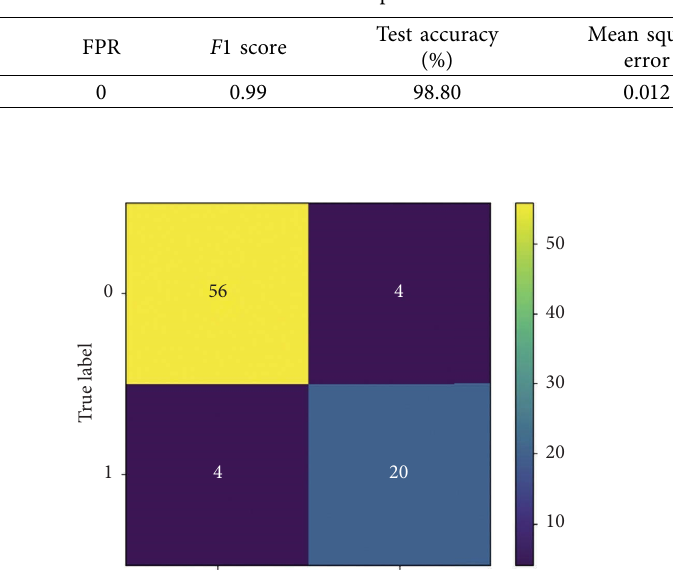
Table 7: SVM classifer parameters.